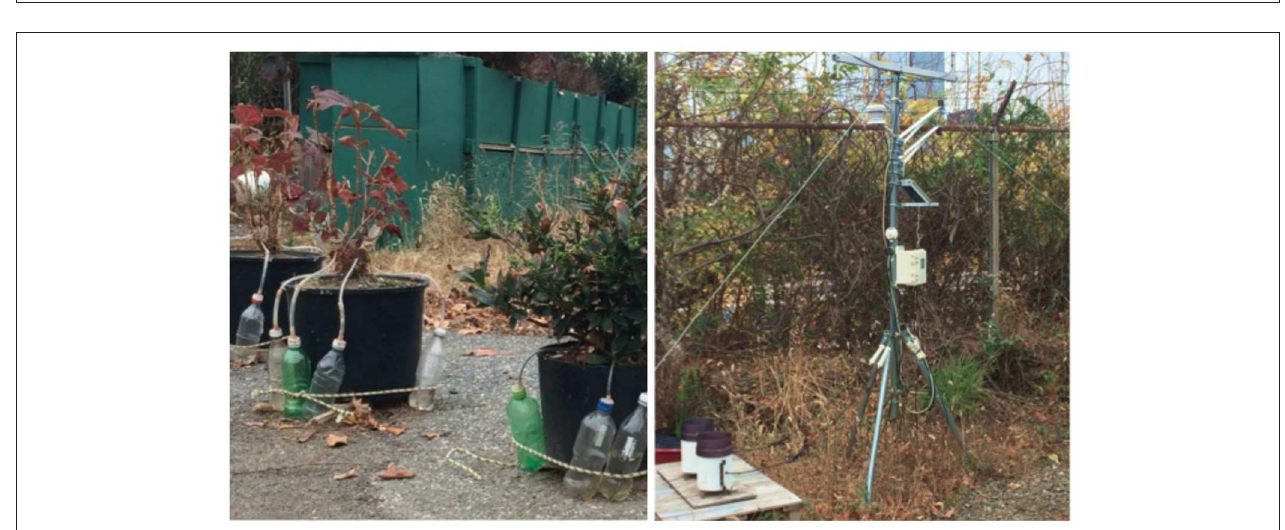
FIGURE 1 | Species studied.